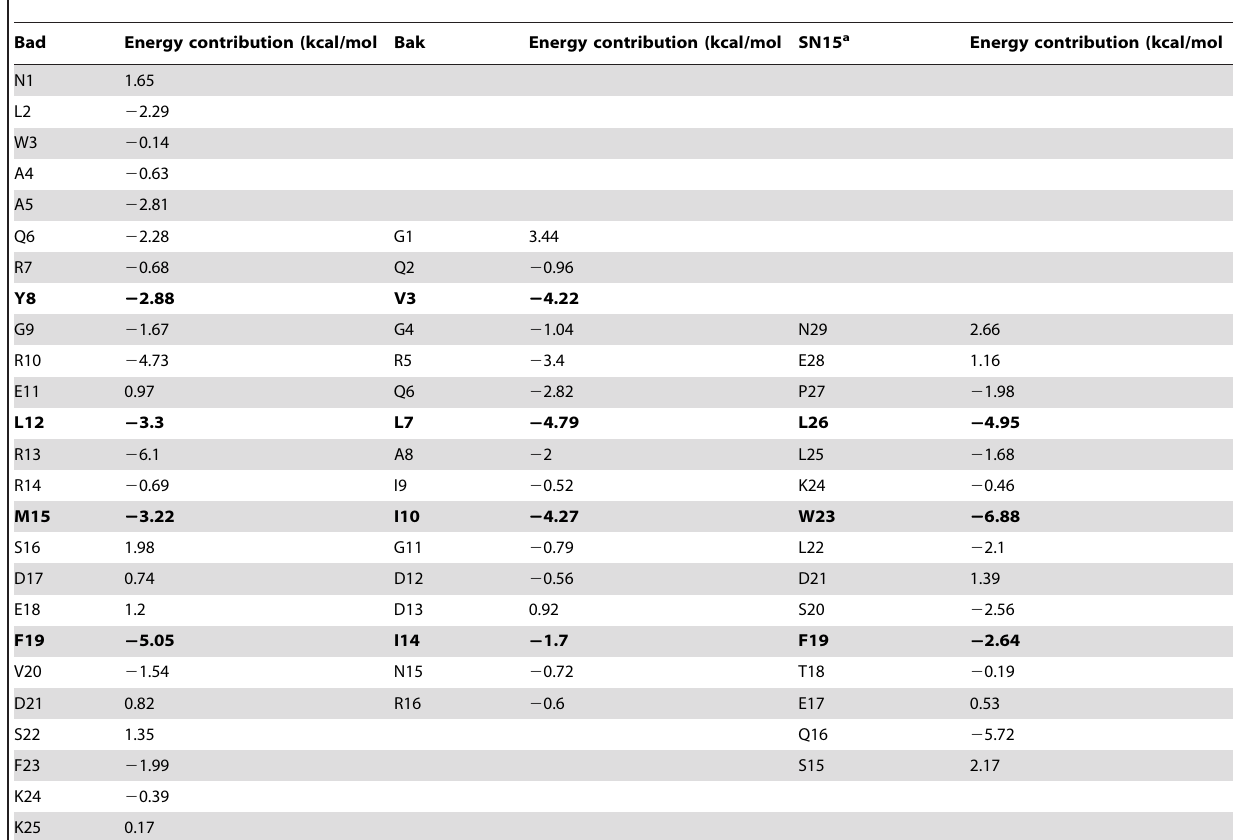
Table 7. Residual contribution of BH3 (Bad, Bak) and SN15 peptides for complex formation with Bcl-X L .